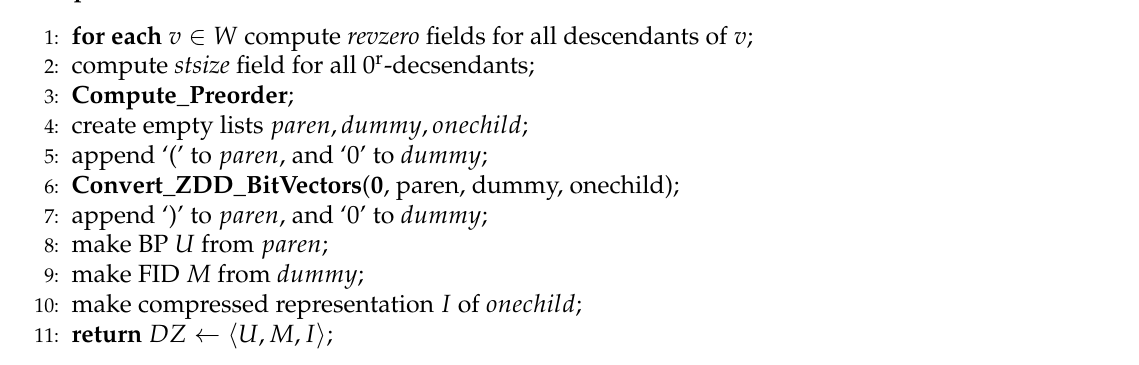
Algorithm 3 Construct_DenseZDD ( W : a set of root nodes of ZDD): Algorithm for constructing the DenseZDD from a source